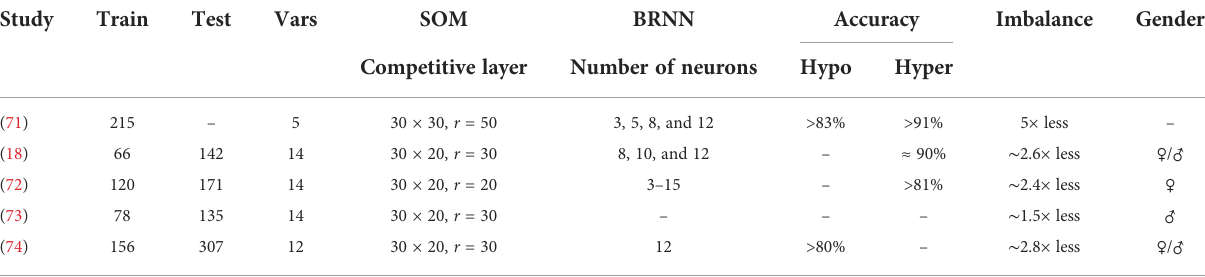
TABLE 5 Overview on the datasets and neural network architectures in a series of studies performed in Tohoku University. Study Train